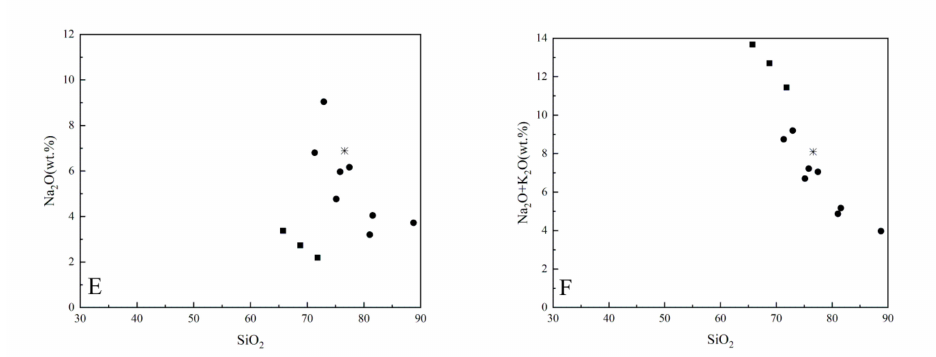
Figure 7. Harker diagram for the pegmatites in Lijiapuzi deposit. Symbols are the same as Figure 6. A-The contents of Al 2 O 3 decrease with the increasing of SiO 2 contents; B- The contents of P 2 O 5 decrease with the increasing of SiO 2 contents; C- The contents of Fe 2 O 3 slightly increase with the increasing of SiO 2 contents; D/E-The contents of K 2 O or Na 2 O show no obvious relationship to those